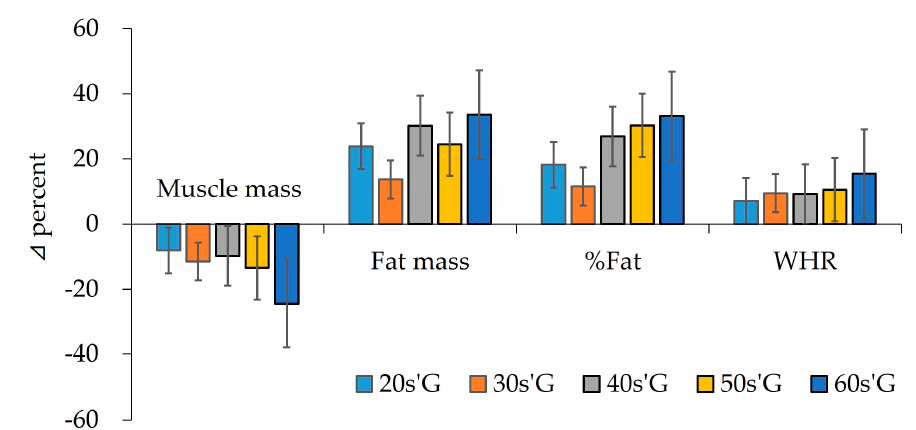
Figure 2. Delta % in body composition factors among groups after detraining.